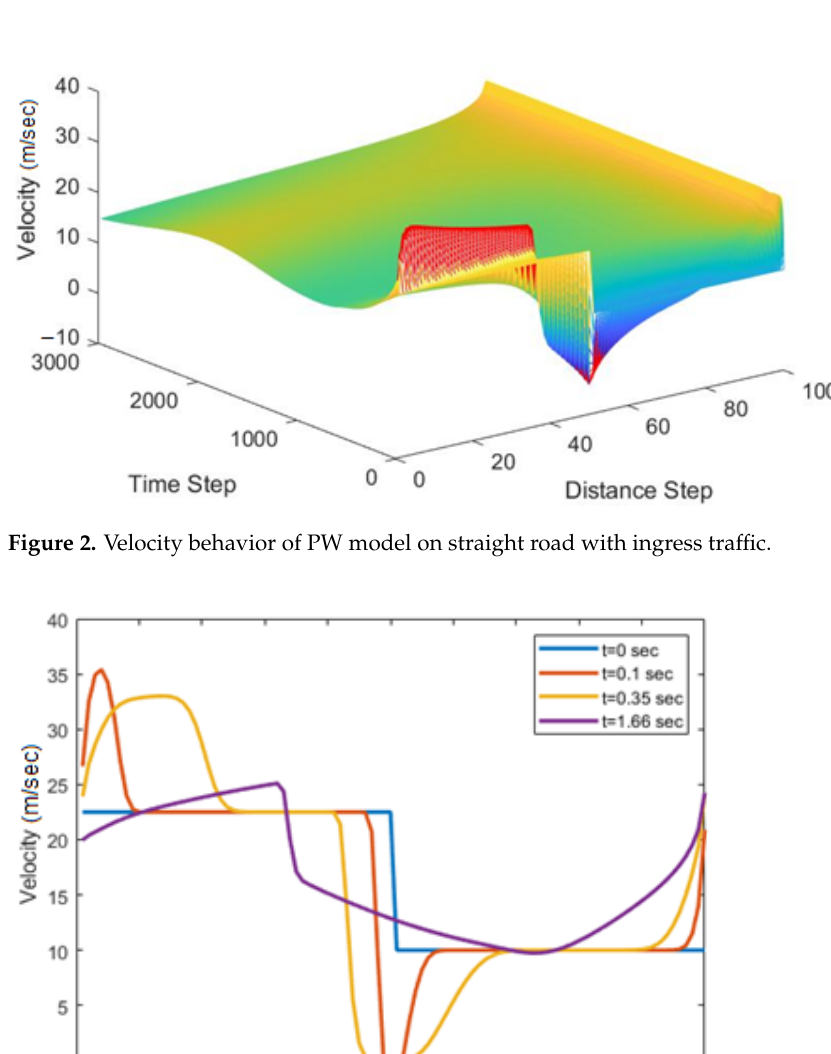
Figure 1. Density behavior of PW model on straight road with ingress traffic.